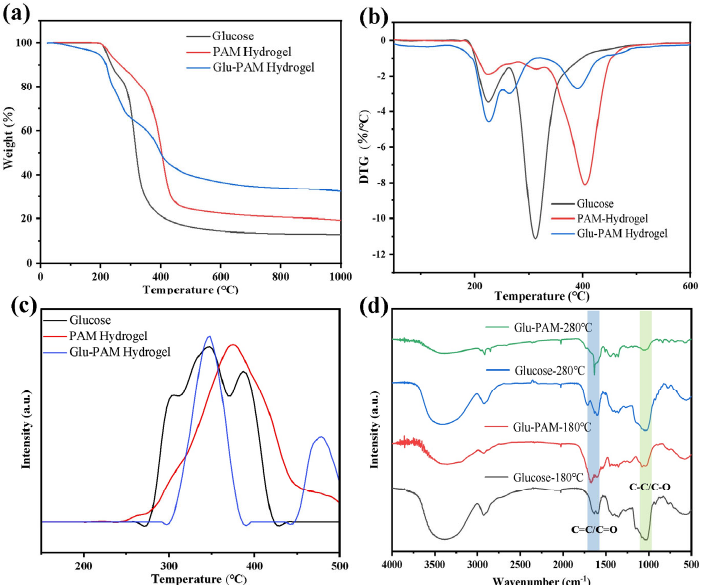
Figure 2. Thermal analysis and structural characterization of Glu ‐ PAM hydrogel: ( a ) TG curve, ( b ) DTG curve, ( c ) TG ‐ MS (CO 2 , m / z = 44) curve, and ( d ) FTIR curve.